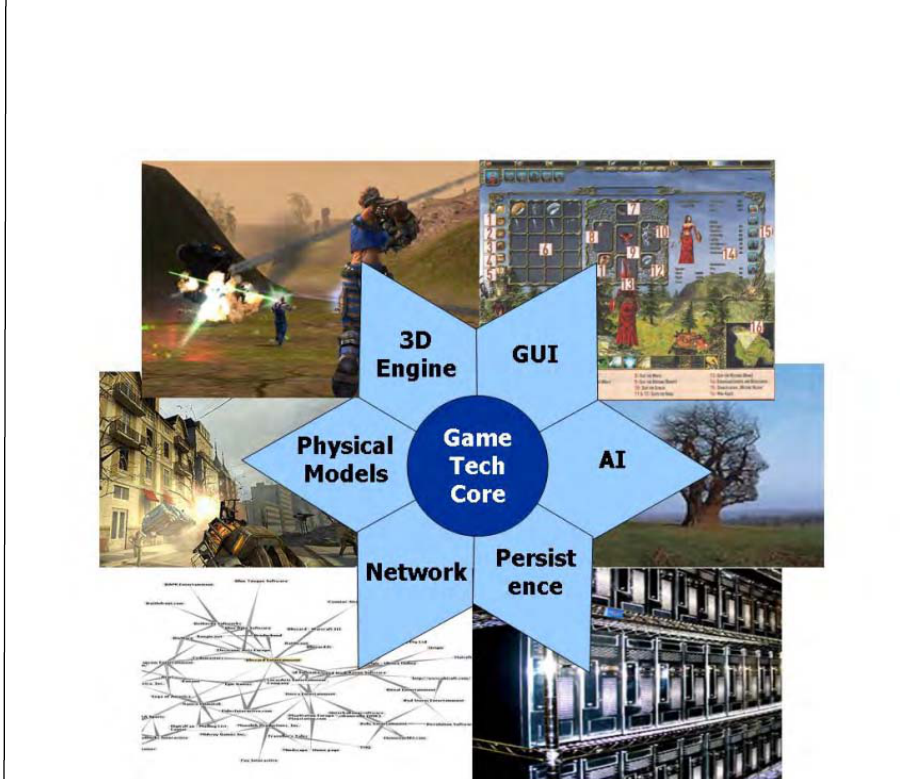
Figure 4 – Key technologies for serious games (Smith, 2008b) Рис . 4 – Ключевые технологии для серьезных игр (Smith, 2008b) Слика 4 – Кључне технологије код озбиљних игара (Smith,